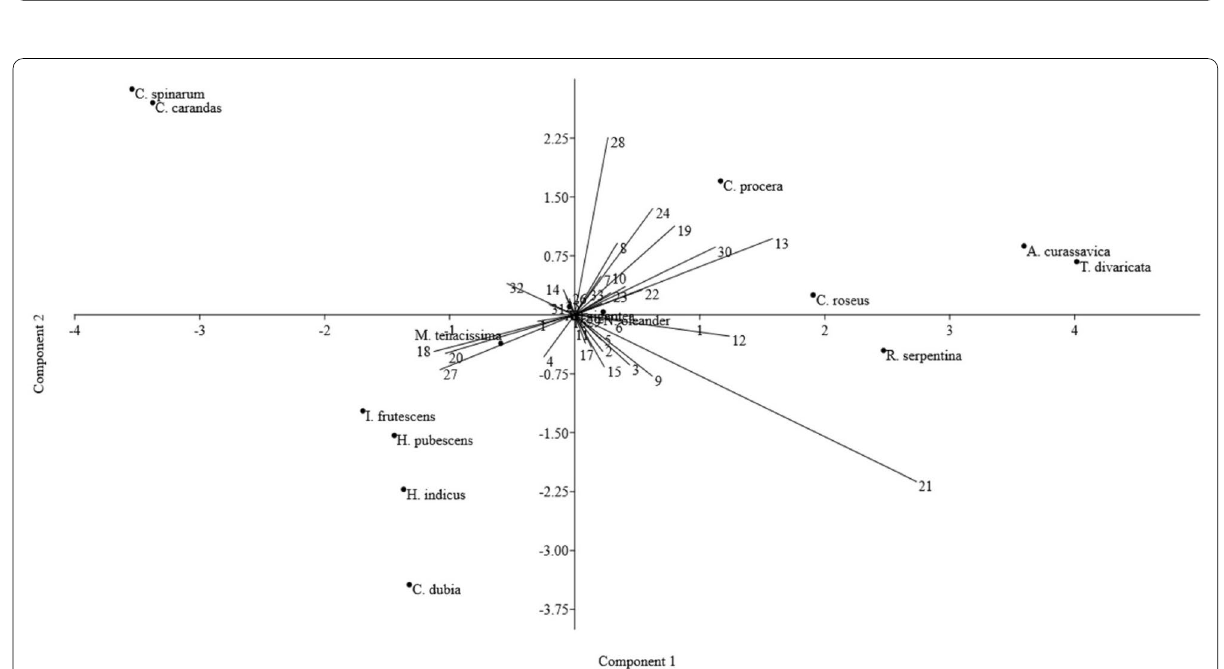
Fig. 5 Scatter plot diagram of PCA showing important RDS characters for the distinction of 14 species of family Apocynaceae used in ISM